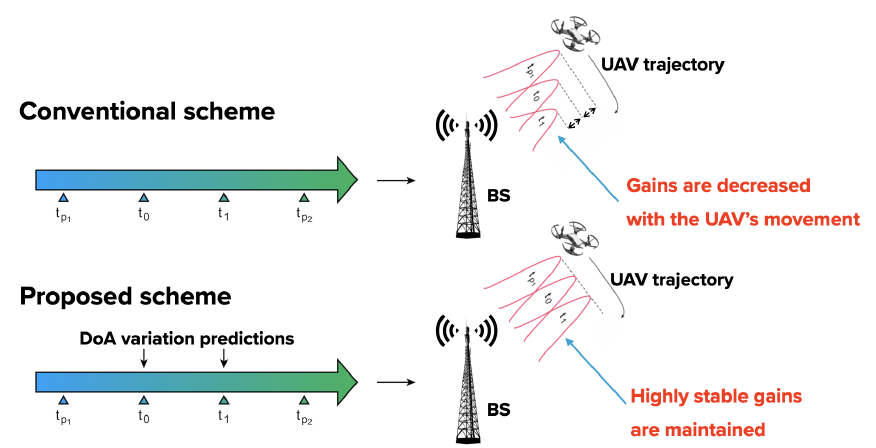
Figure 1. The proposed beamforming scheme versus conventional beamforming scheme for the highly- mobile UAV communication scenario. The proposed scheme updates DoA information in real-time to maintain highly stable gains in uplink connections.